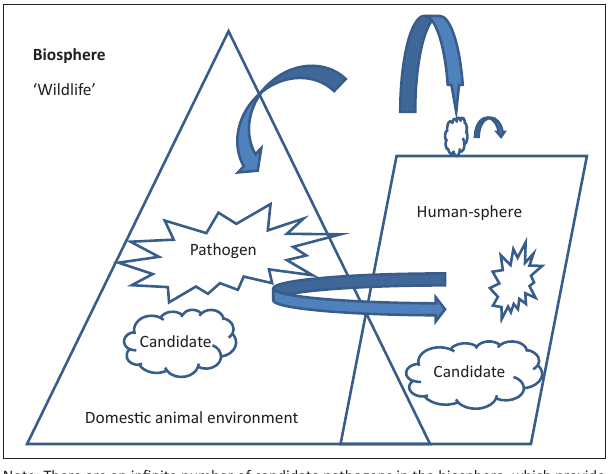
FIGURE 2: Model of pathogen evolution from the biosphere through contact between wildlife and domestic animals or